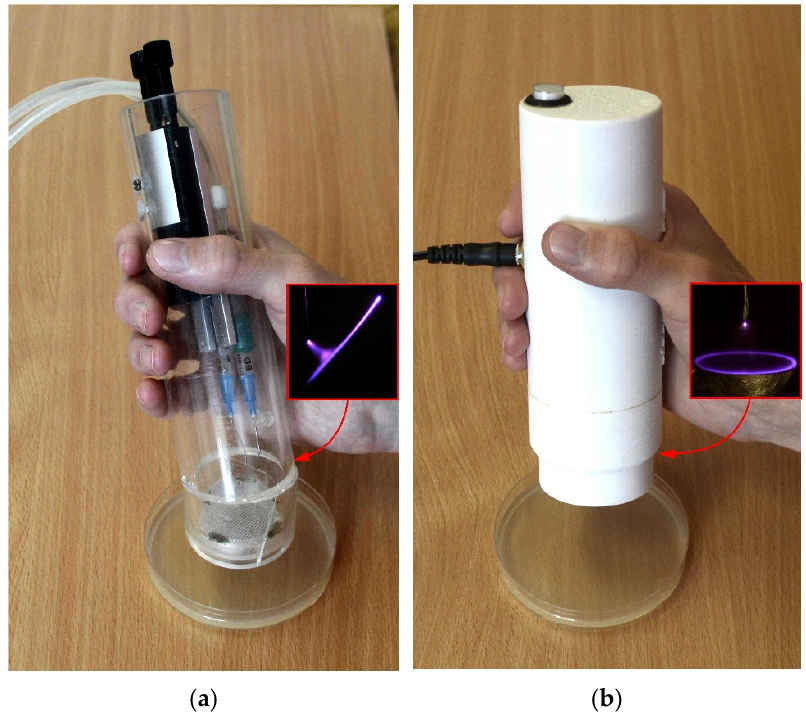
Figure 1. The developed sources of NTP: ( a ) source of NTP based on the cometary discharge; ( b ) source of NTP based on the point-to-ring discharge.